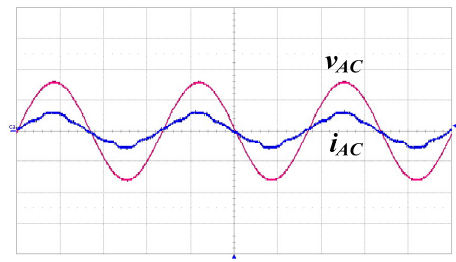
Figure 13. Measured input utility ‐ line voltage v AC (100 V/div) and current i AC (0.5 A/div); time scale: